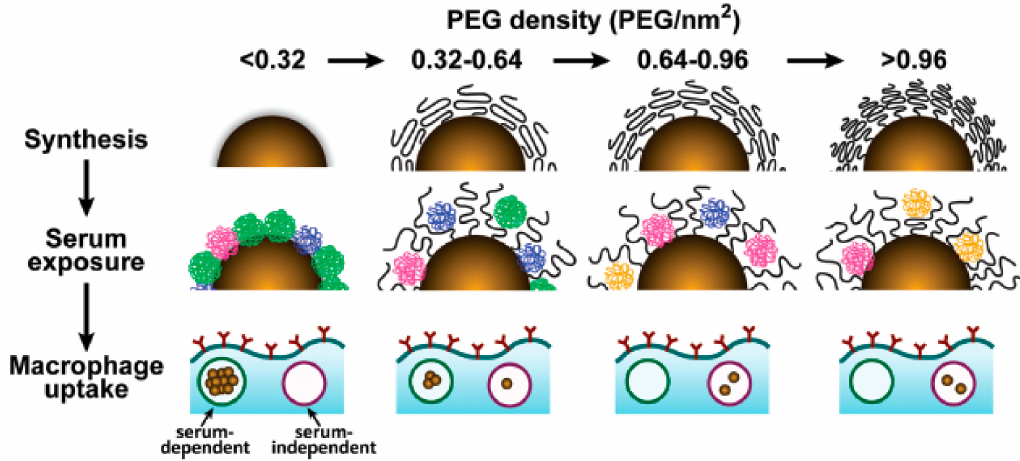
Figure 5. Cartoon showing the relation between the PEG density, protein corona, and macrophage uptake. Reprinted (adapted) with permission from reference [34]. Copyright (2012) American Chemical Society.